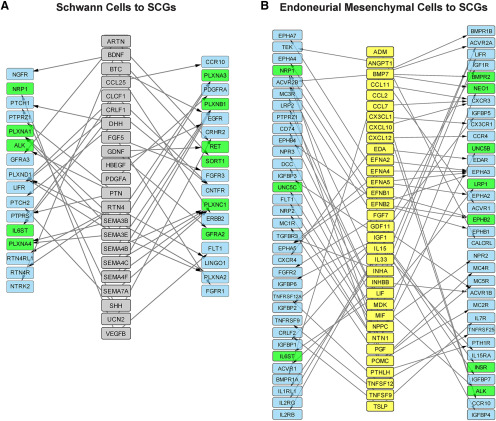
Predicted unidirectional ligand-receptor interactions between injured sciatic nerve Schwann cells or endoneurial mesenchymal cells and sympathetic neurons (see also Extended Data Fig. 6-1). Models showing predicted unidirectional interactions between the ligands most highly expressed by injured nerve Schwann cells (A) or endoneurial mesenchymal cells (B) and their receptors on cultured sympathetic neurons (SCGs). Ligands are shown in the central columns in A, B and are color coded as in Figure 5 (Schwann cell ligands in gray and endoneurial mesenchymal cell ligands in yellow). Receptors are shown on either side of the ligand column and also include coreceptors that are well-characterized components of receptor complexes. Receptors that were observed at both the transcriptomic and proteomic levels are colored green while those defined only at the transcriptomic level are colored blue. Arrows indicate directionality of interactions. Note that many ligands interact with multiple receptors and, conversely, that multiple ligands are sometimes predicted to share receptors.